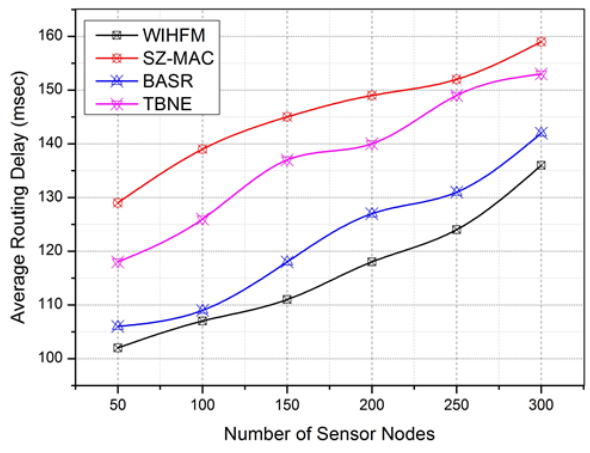
Figure 12. Average Routing Delay.